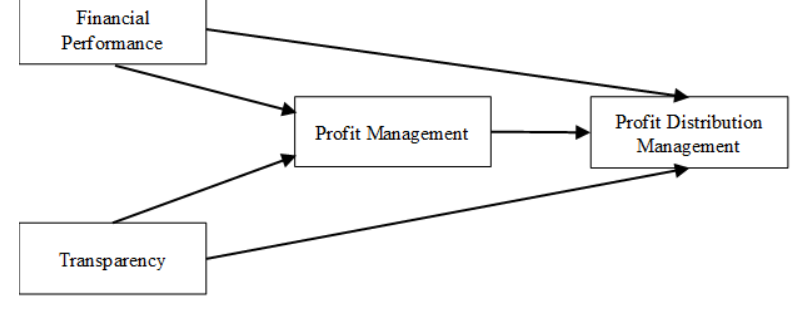
Figure 1: Empirical Research